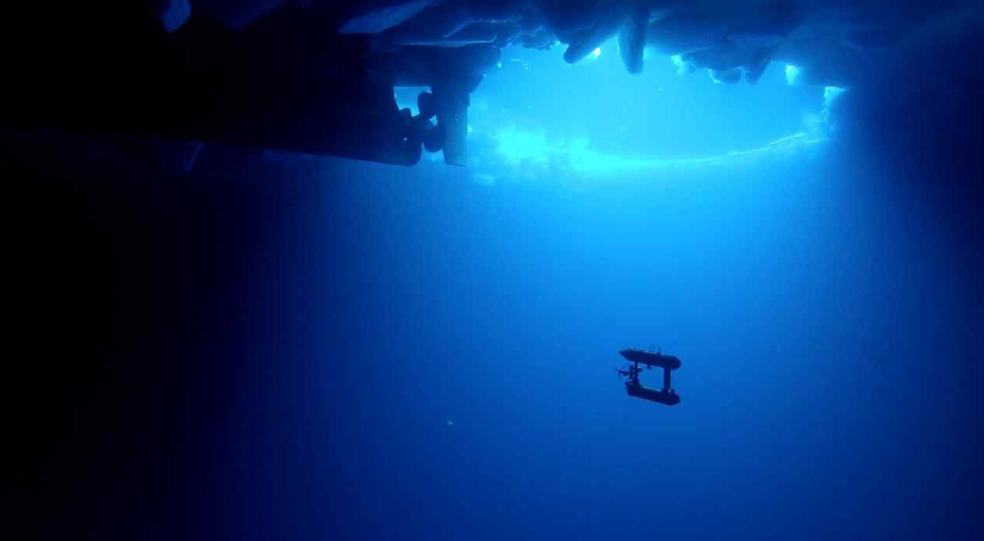
Figure 6. The Seabed-Class Jaguar AUV conducting an upward-looking multibeam survey of Antarctic sea ice with the R/V Aurora Australis visible in the background. Image Credit: K. Meiners, G. Williams, and H. Singh, Australian Antarctic Division and Woods Hole Oceanographic Institution. Reproduced with